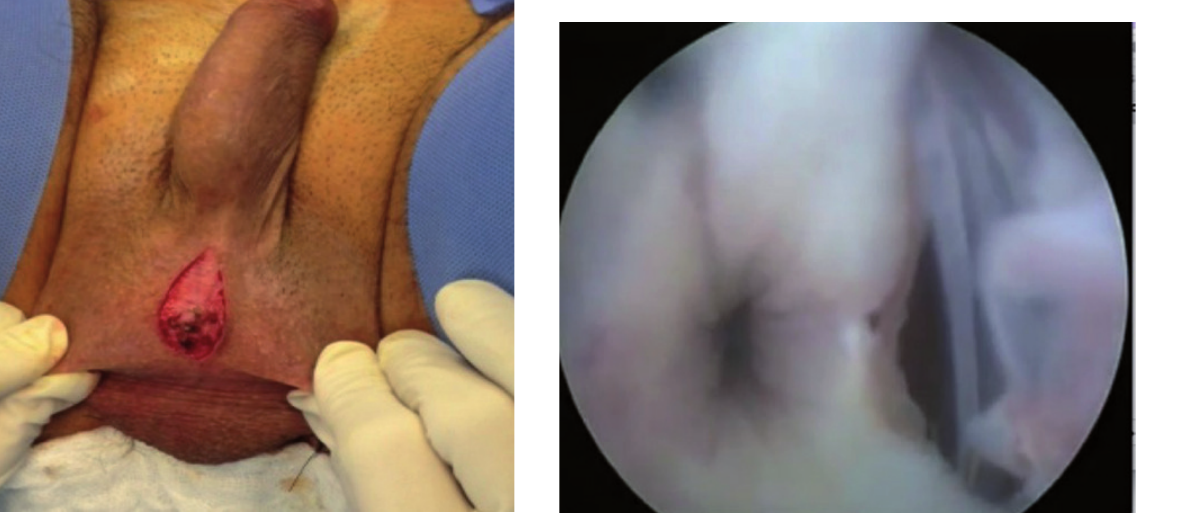
urethrocistoscopy.Figure approach.